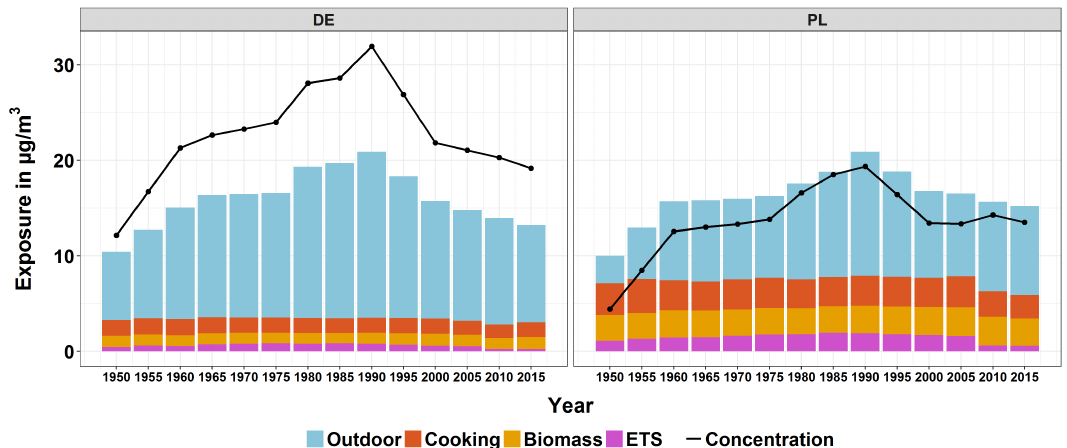
Figure 3. Population-weighted arithmetic mean NO 2 exposure by source (infiltration from outdoors, cooking, wood burning, smoking) for Germany and Poland from 1950 to 2015. The black line indicates the average background NO 2 concentration in the two countries.